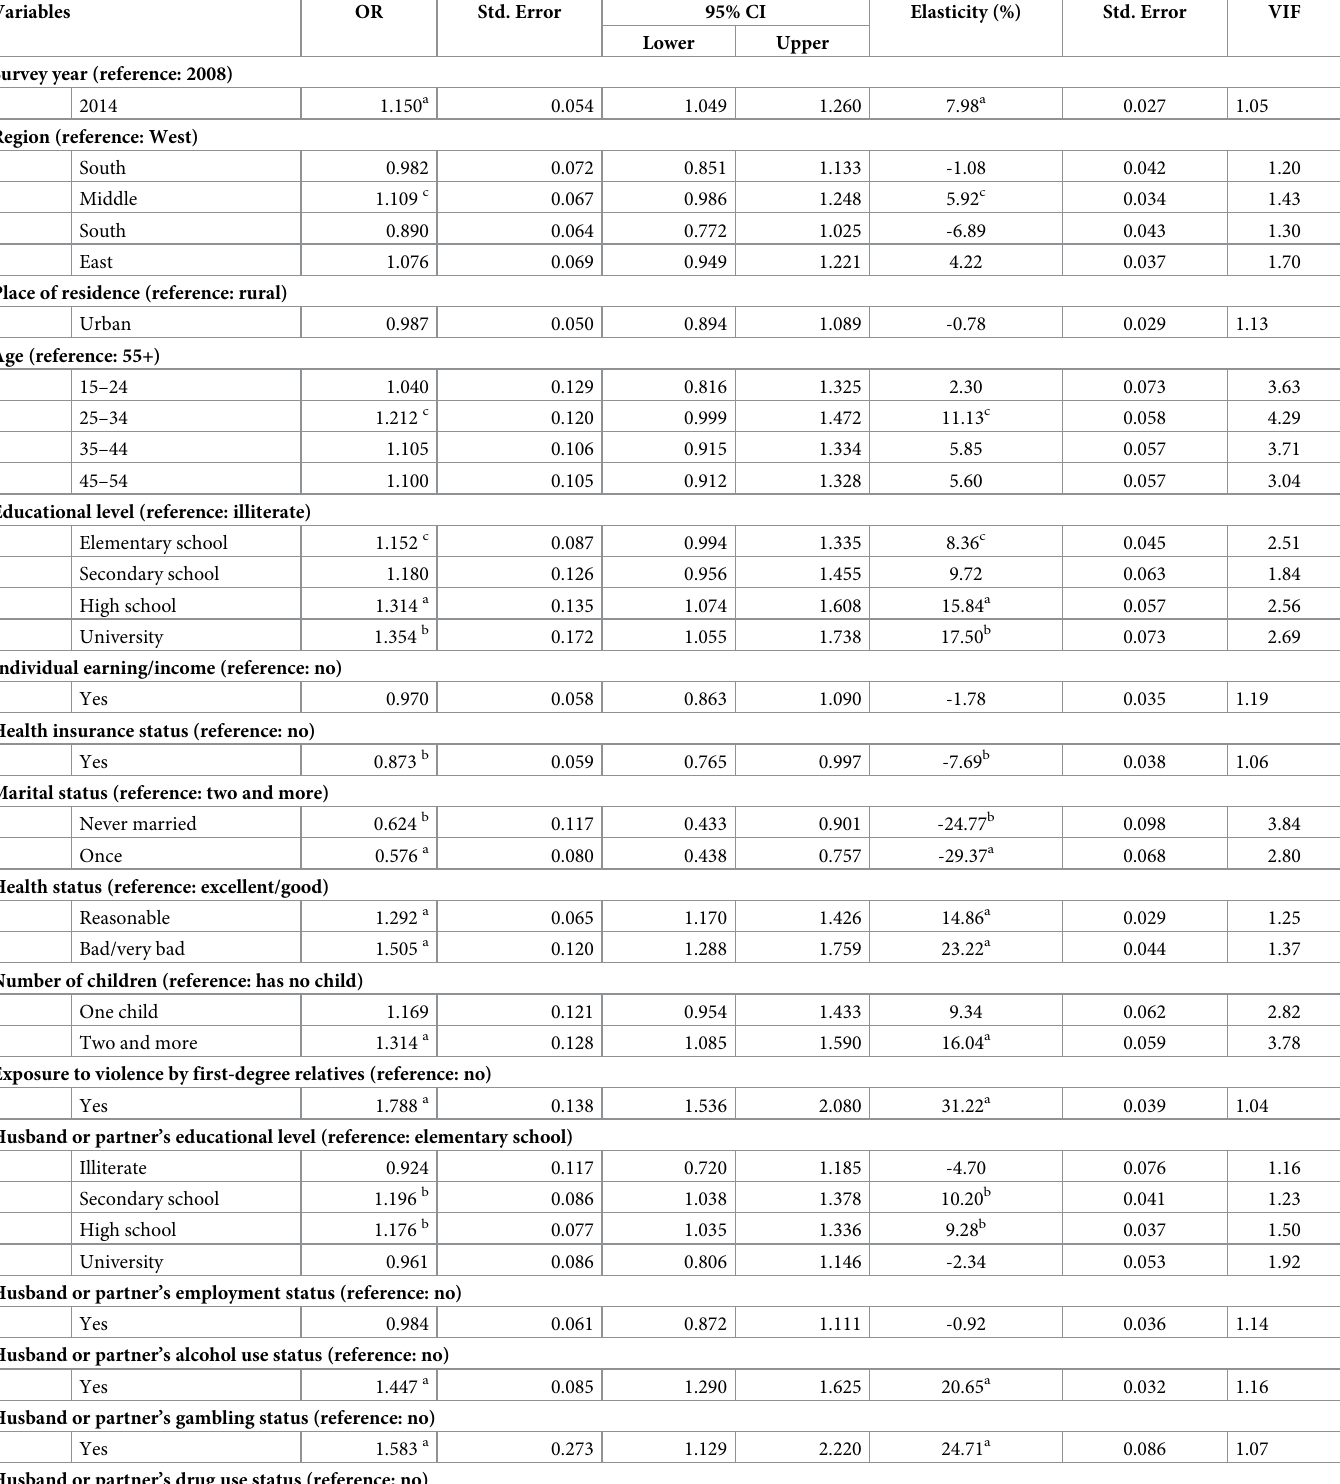
Table 2. Estimated binary logistic regression model results and marginal effects related to factors affecting women’s exposure to verbal and psychological